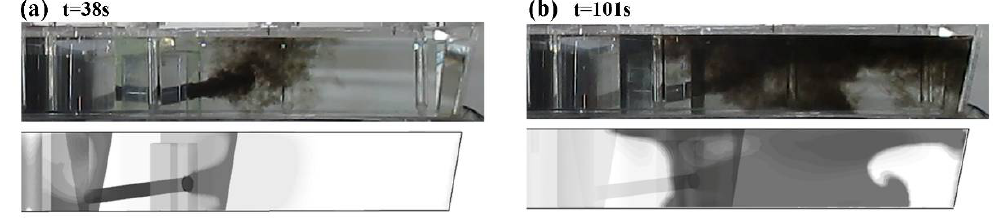
Figure 15. Tracer dispersion comparison between experiment (upper) and simulation (below) for case A0: ( a ) 38 s, ( b ) 101 s.